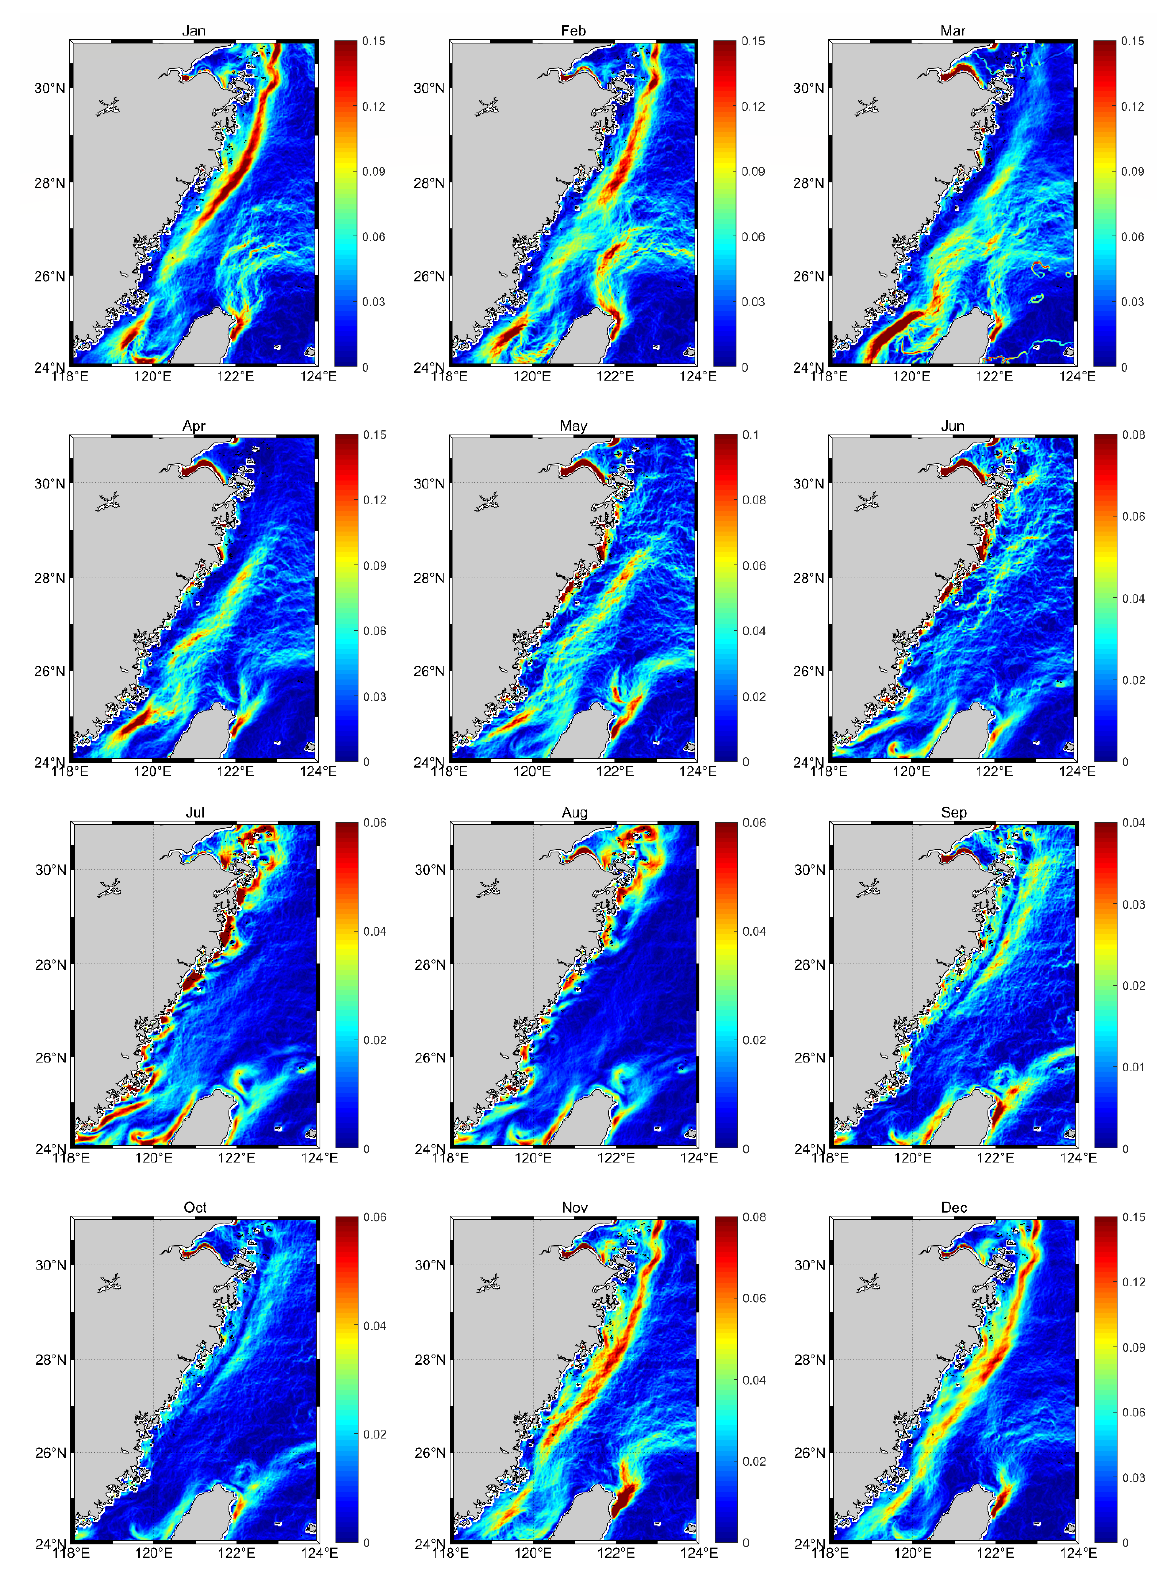
Figure 5. Long-term (2015–2020) mean monthly maps of SST gradient magnitude GM ( ◦ C/km). Color scales are adjusted monthly and cut off below peak values of GM in order to show fine (submesoscale) fronts. The peak values of GM at some grid points could be as high as 0.4 ◦ C/km.